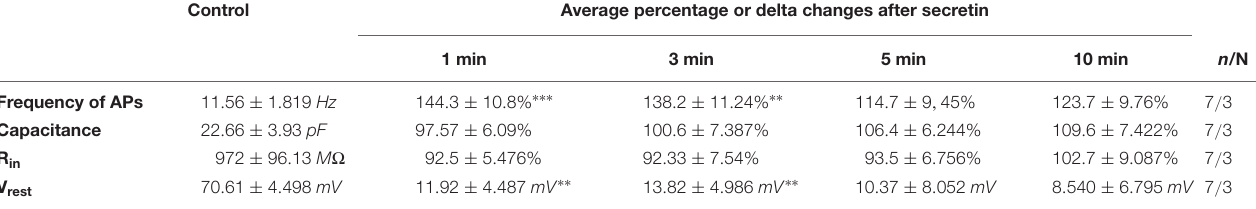
TABLE 3 | Effect of secretin on the evoked action potentials (APs), the passive membrane properties and V rest . Control